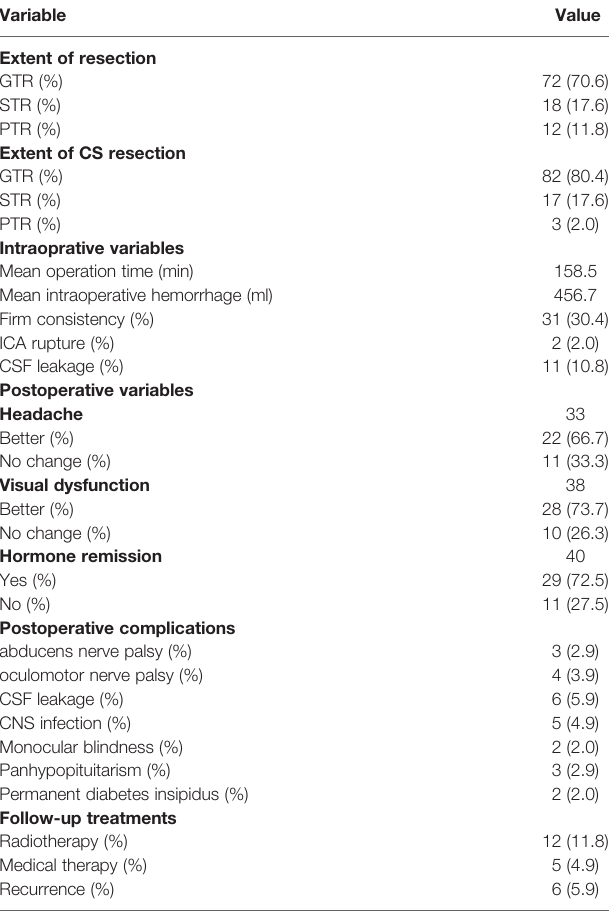
TABLE 2 | Surgical results and postoperative complications in the 102 patients who underwent transsphenoidal endoscopic surgery for pituitary adenomas in Knosp Grade